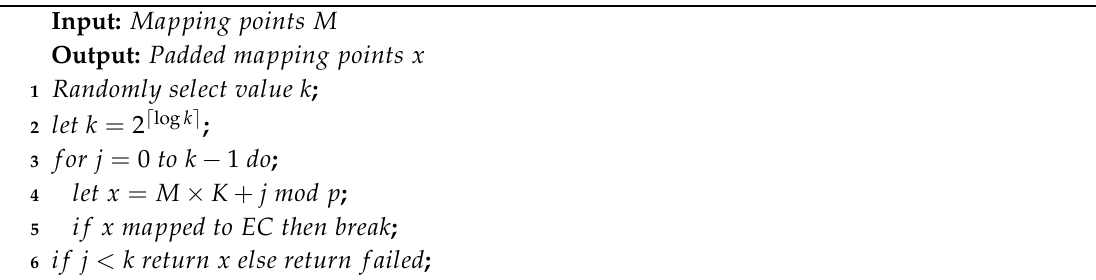
Algorithm 1: The proposed enhanced probability method